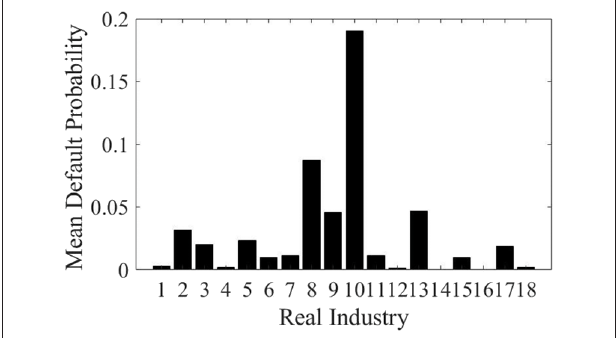
FIGURE 4 | The mean credit risk of the credit industry under the simulation of 1,000